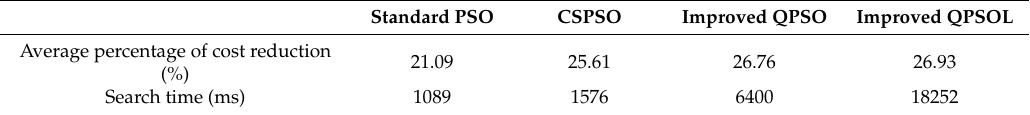
Table 5. Results of the standard PSO and its variants after